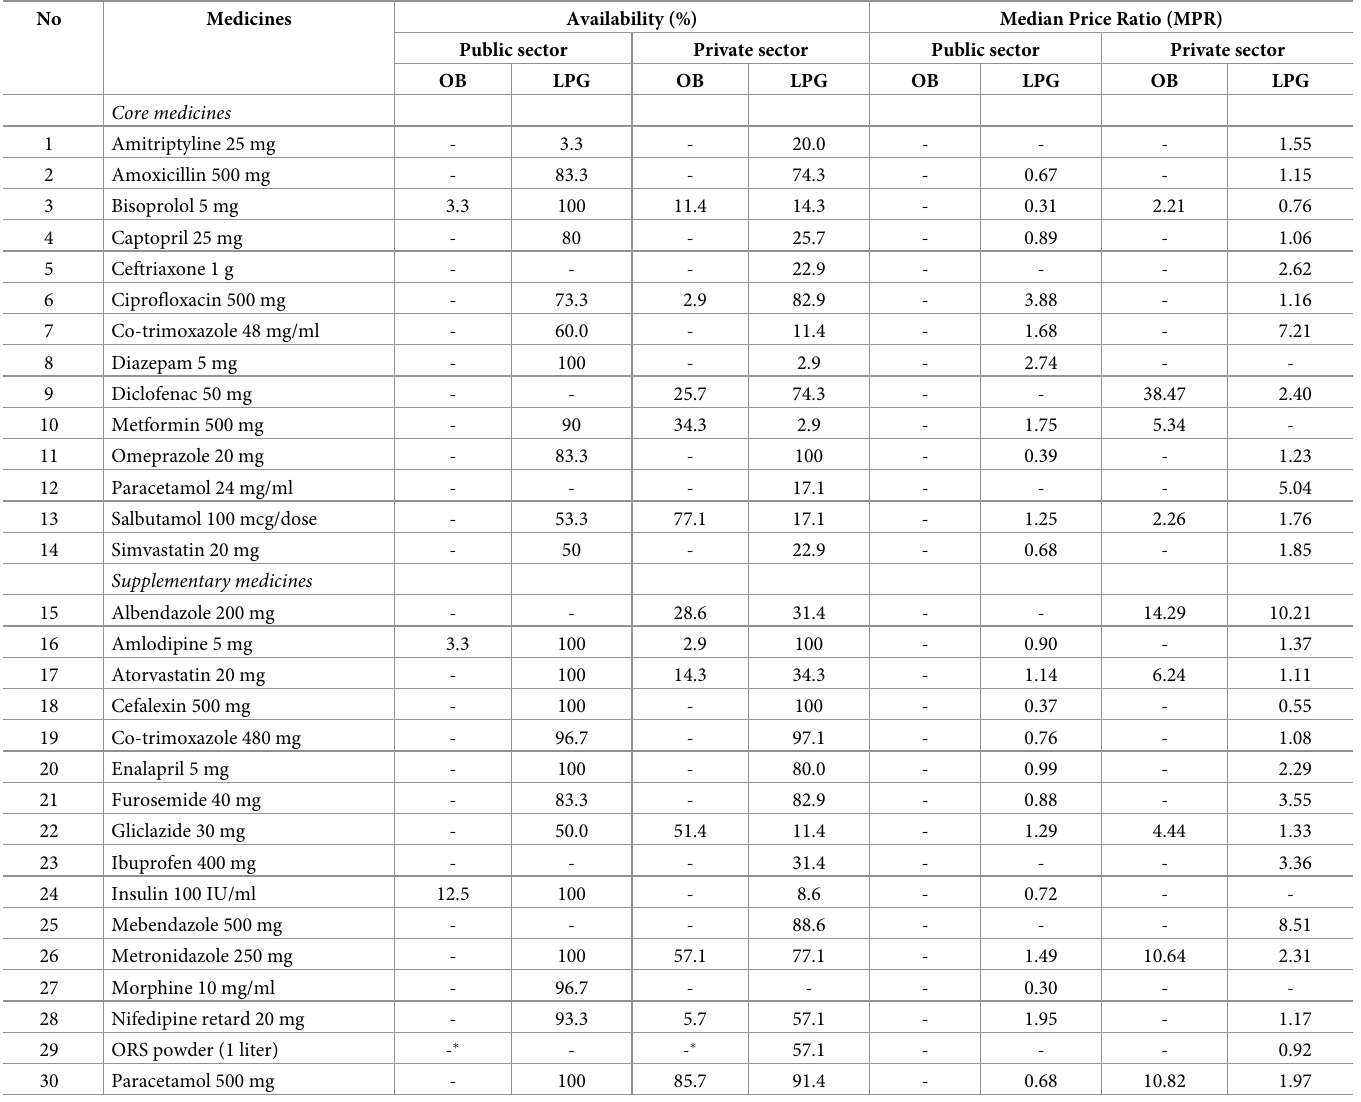
Table 1. The availability and median price ratio of each essential